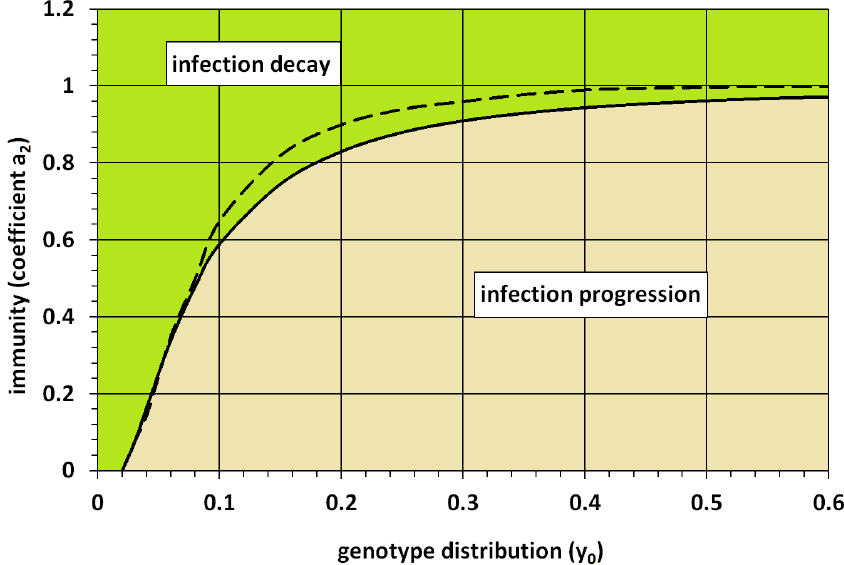
Figure 5. The critical value of immunity (coefficient a 2 ) is shown as a function of the width of the genotype distribution ( y 0 ). If the value of immunity exceeds the critical value, then infection is eliminated. Otherwise, it progresses. Solid line represents the results of 2D simulations, and λ ( y 0 ) for the 1D problem. The values of parameters: dashed line is given by the formula a 2 = 1 − D x = D y = 0.005, b = 1, k = 1, f ( u ) = ( a 1 u + a 2 ) e − a 3 u , a 1 = 15, and a 3 =